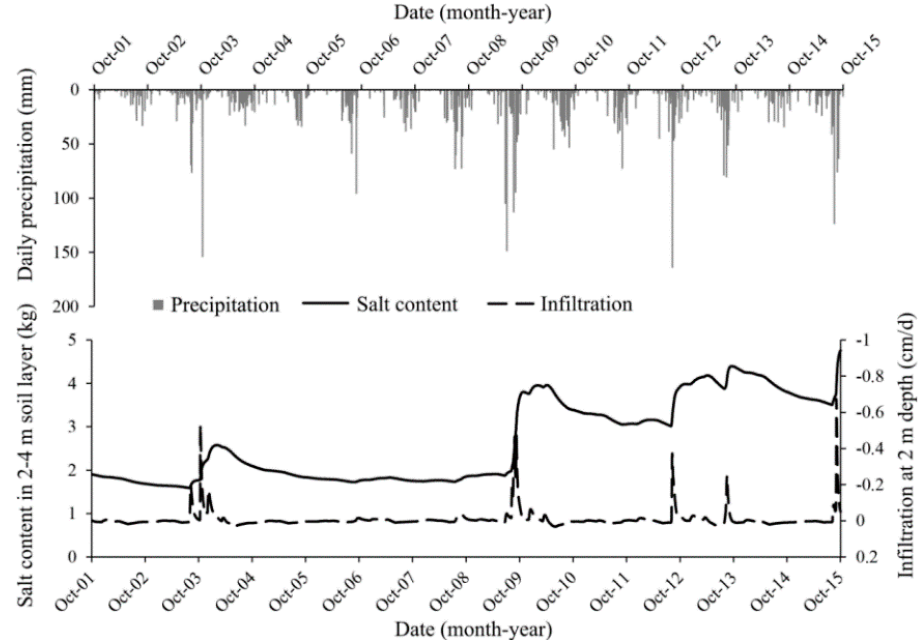
Figure 8. Comparisons between salt content in the 2–4 m soil layer, water infiltration at 2 m observation depth and daily precipitation for the 15-year period in Hebei Low Plains in North China.